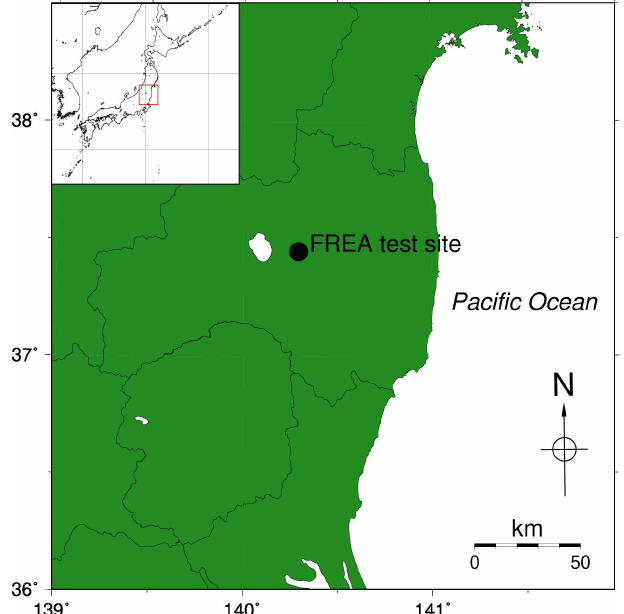
Figure 1. Location of the FREA test site in Koriyama.